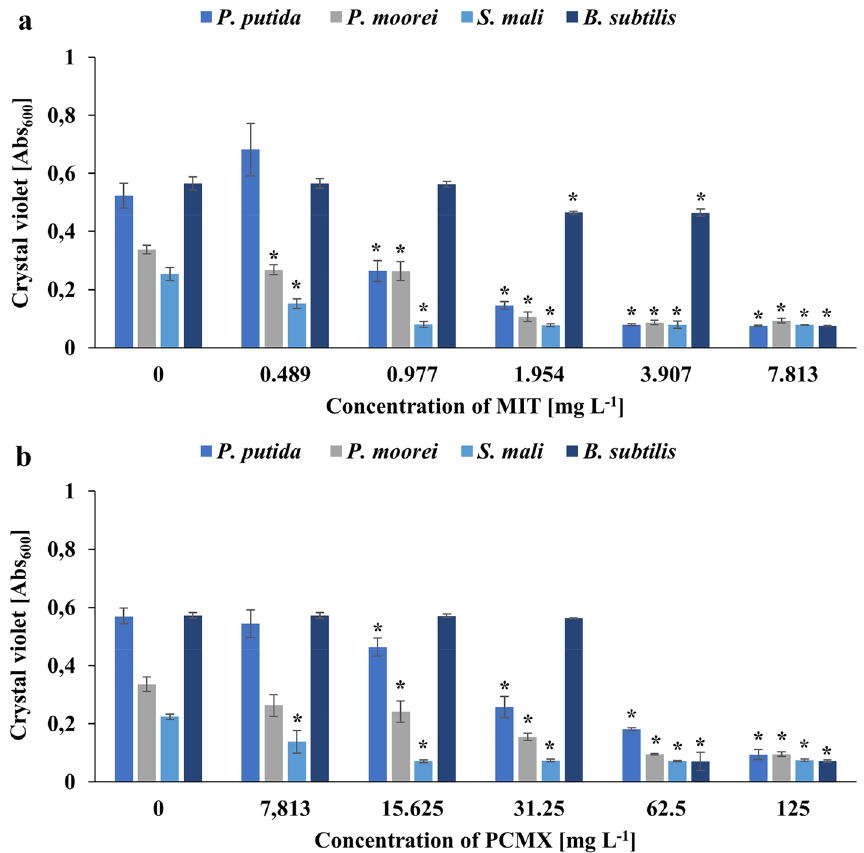
Figure 3. Effect of MIT ( a ) and PCMX ( b ) on biofilm formation by the tested strains. Data are expressed as the average of crystal violet absorbance ± SD (n = 4). The presented results were analysed using the Mann ‒ Whitney U test with *p <